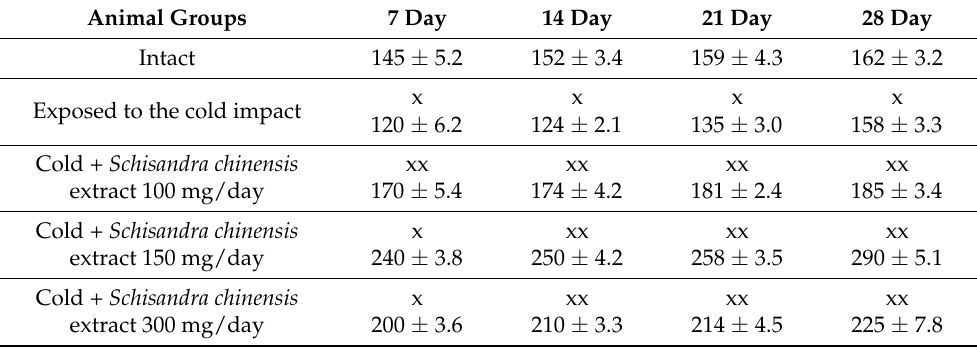
Table 5. Duration of swimming of rats with prolonged cold stress and against the background of the use of Schisandra chinensis extract (in